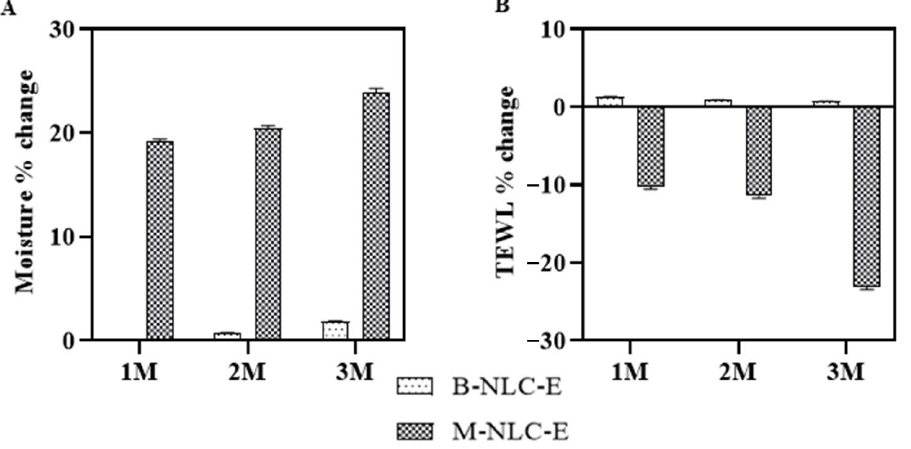
Figure 13. The moisture changes ( A ) and TEWL loss ( B ) after 1st (M1), 2nd (M2) and 3rd month (M3) of use of B-NLC-E and M-NLC-E.